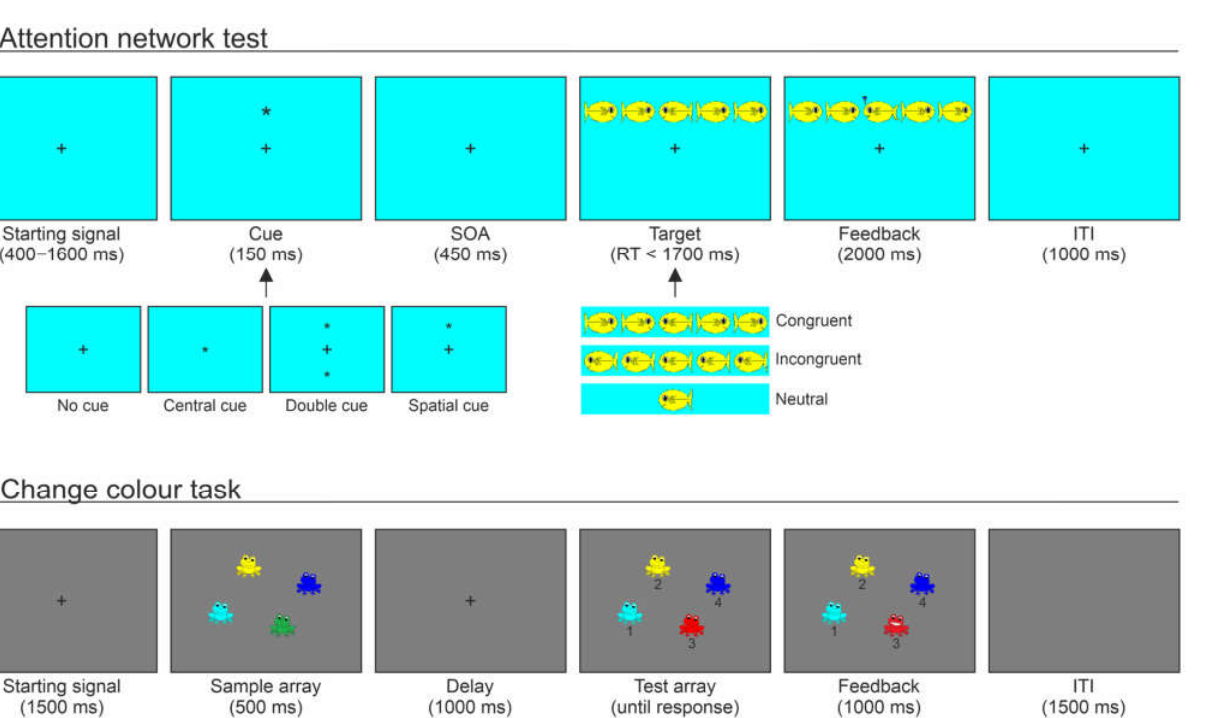
sponse, consisting of either the central target fish blowing bubbles and a “Woohoo!” sound (correct response), or a single tone with no animation of the fish (incorrect response). ( B ) Schematic diagram showing the sequence of events during one example trial of the CCT, here adapted for children. After a starting signal, a sample array including a variable set size of 2, 4, or 6 coloured frogs was presented. After a maintenance period, a test array was presented, identical to the sample array, except that one frog always changed in colour. Participants digited on a keyboard the number cor- responding to the frog that changed in colour, and then a feedback display was provided, consisting of either a smiling frog replacing the target frog along with a “Woohoo!” sound (correct response), or a single tone with no frog animation (incorrect response). During the task, the participants were presented with 96 trials, derived from the com- bination of the four cue conditions (no cue, central cue, double cue, and spatial cue), two target locations (above vs. below fixation), two target orientations (right vs. left), three target types (congruent, incongruent, and neutral), and two repetitions, for approximately